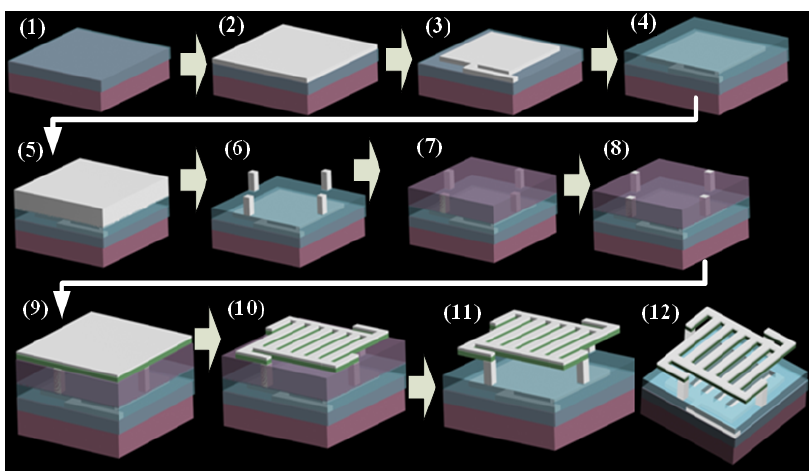
Figure 6 . GLM fabrication